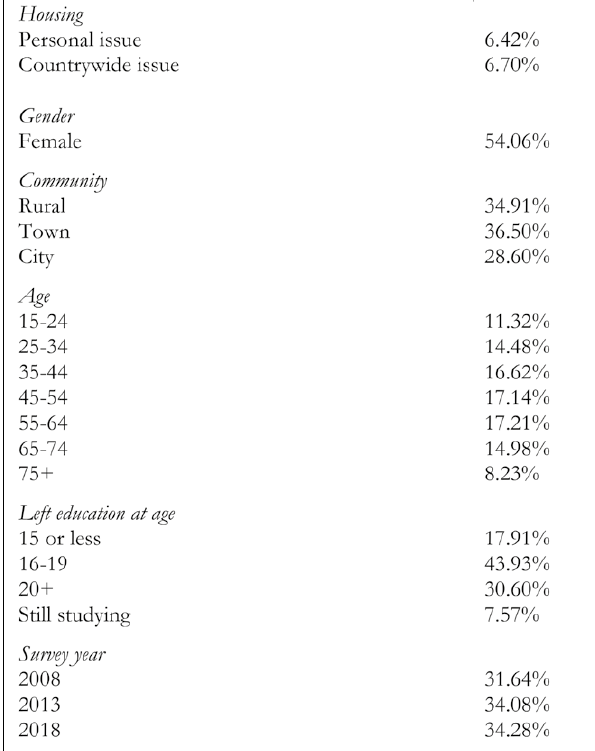
Table 1: Descriptive overview